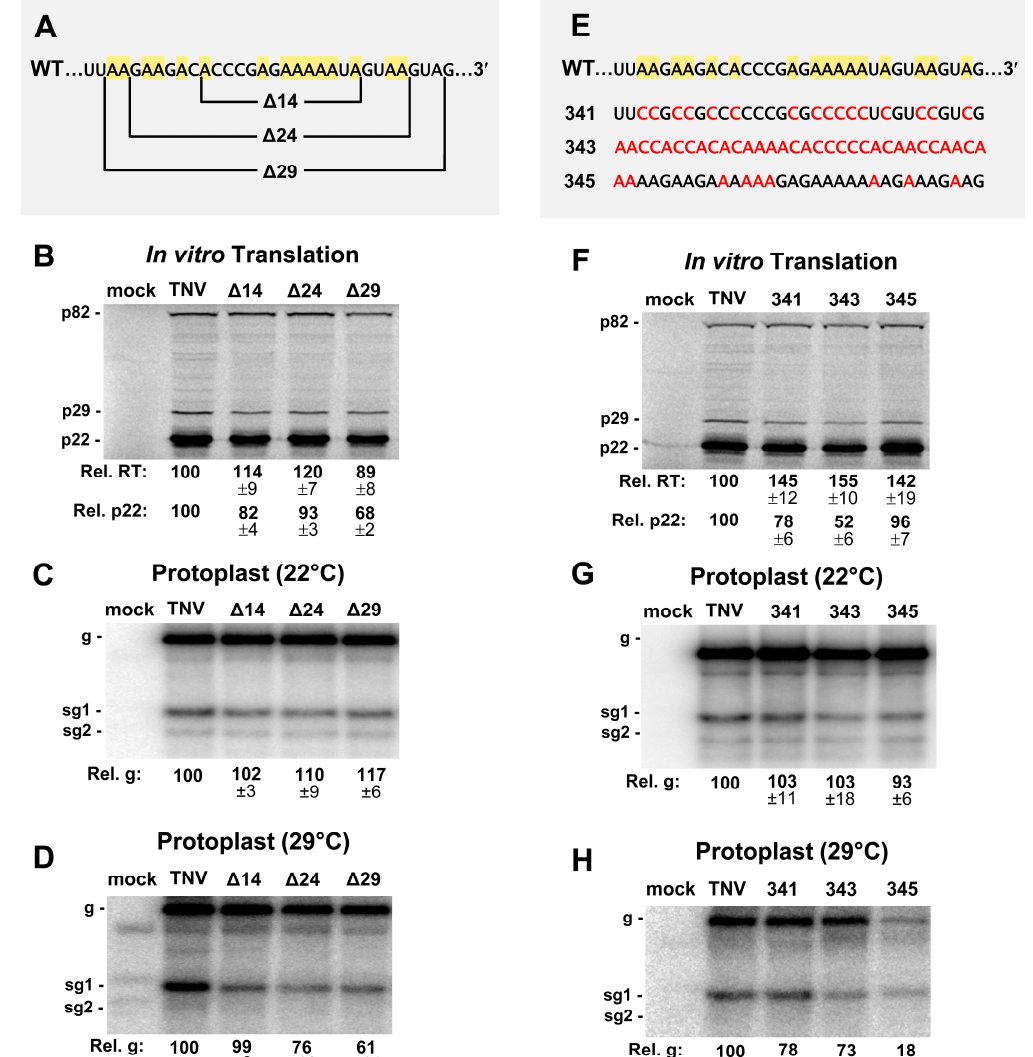
Figure 6. Mutational analysis of the intervening sequence (IS). ( A ) Deletions made in the 32 nucleotide long IS region ( ∆ 14, ∆ 24, ∆ 29). Adenylate residues are highlighted in yellow in the wt sequence. ( B ) In vitro translation analysis of the IS mutants in panel A. ( C and D ) Northern blot analysis of protoplast infections with deletion mutants in panel A at ( C ) 22 ◦ C and ( D ) 29 ◦ C. ( E ) Substitutions in the IS are shown in red (341, 343, 345) and adenylate residues are highlighted in yellow in the wt sequence. ( F ) In vitro translation analysis of IS mutants in panel E. ( G and H ) Northern blot analysis of protoplast infections with deletion mutants in panel E at ( G ) 22 ◦ C and ( H ) 29 ◦ C.